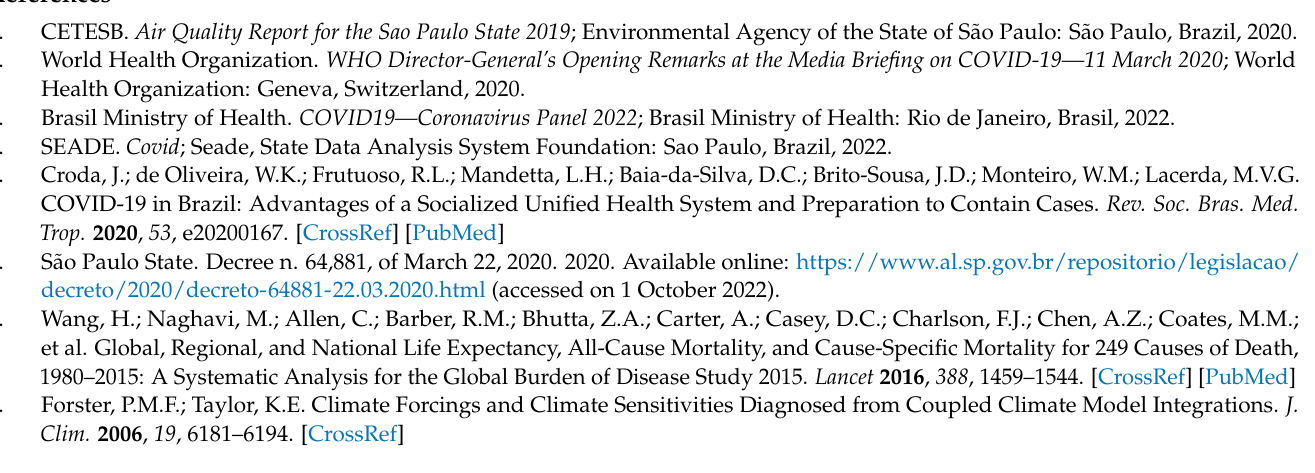
Figure S5. Total monthly precipitation for MASP during April–May of 2017–2019 (pre-pandemic) and 2020 (during the pandemic) from INMET data; Figure S6. Comparison of monthly average AOD (550 nm) during April and May of 2020 (pan-demic) and during the same period of 2017, 2018, 2019 (pre- pandemic) from AERONET versus MERRA-2